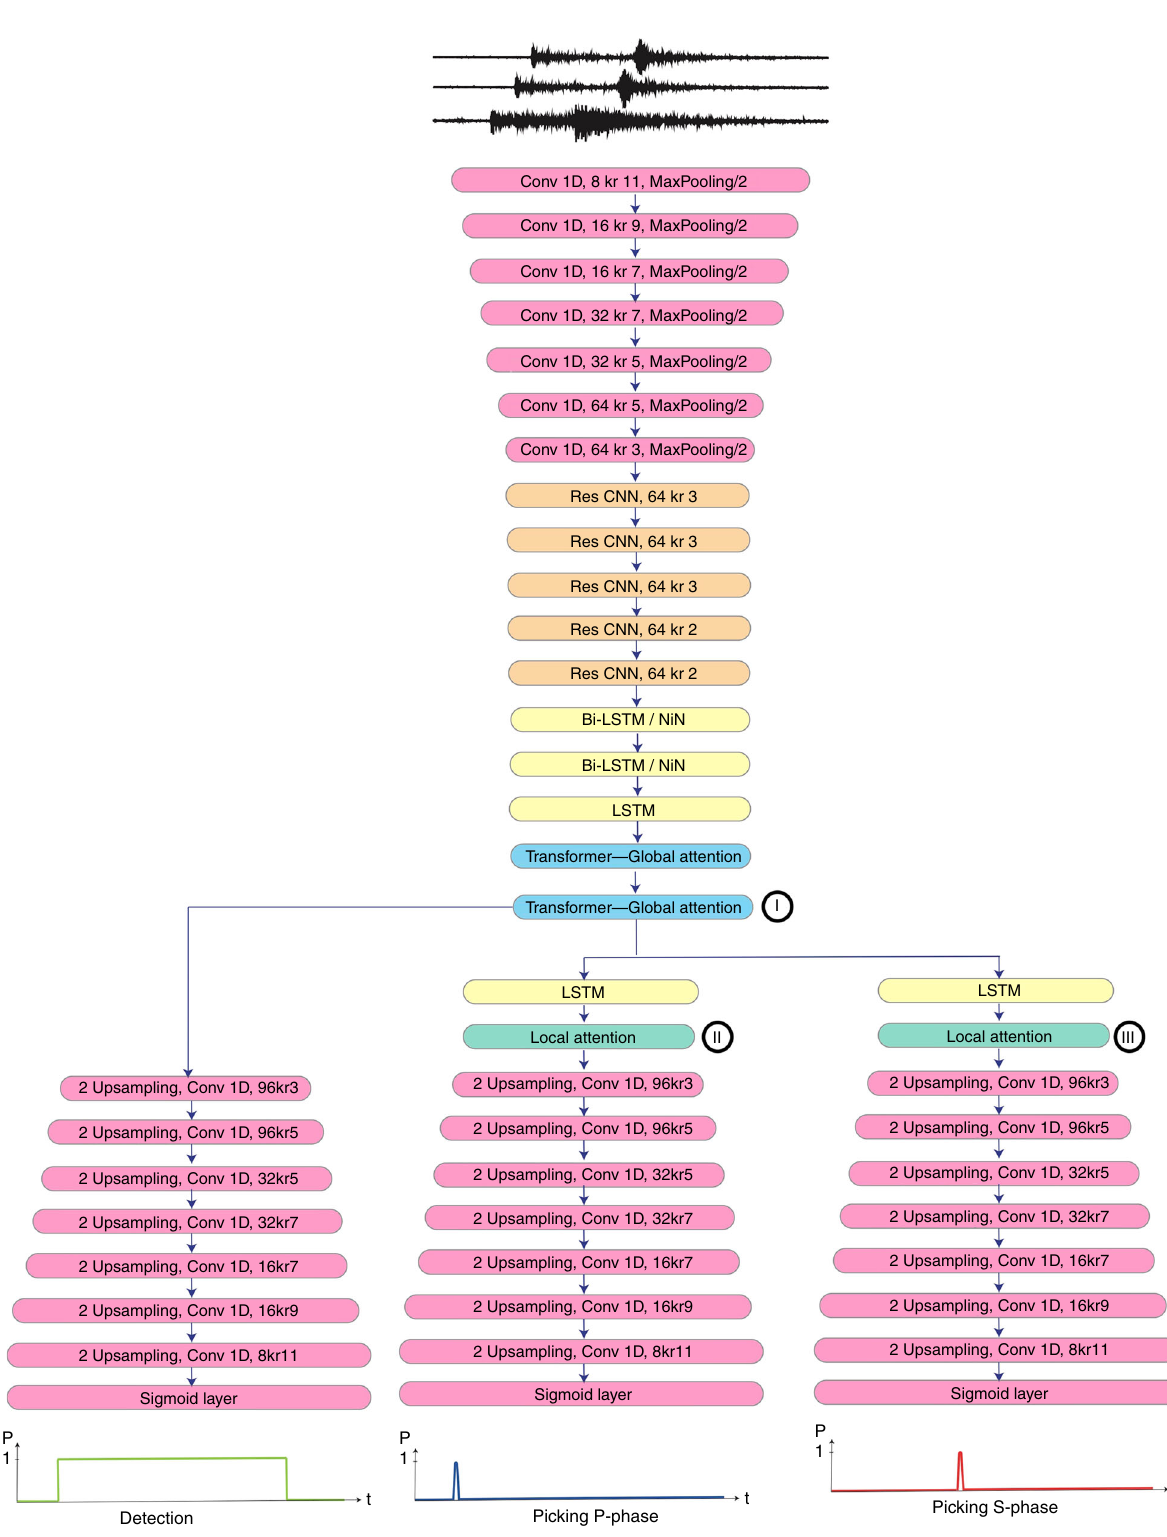
Training . For both convolutional and LSTM units, all the weight and fi lter matrices were initialized with a Xavier normal initiali- zer 14 and bias vectors set to zeros. We used ADAM 15 with varying learning rates for optimization while the learning rate varied during training. The model took O(89) hours to complete